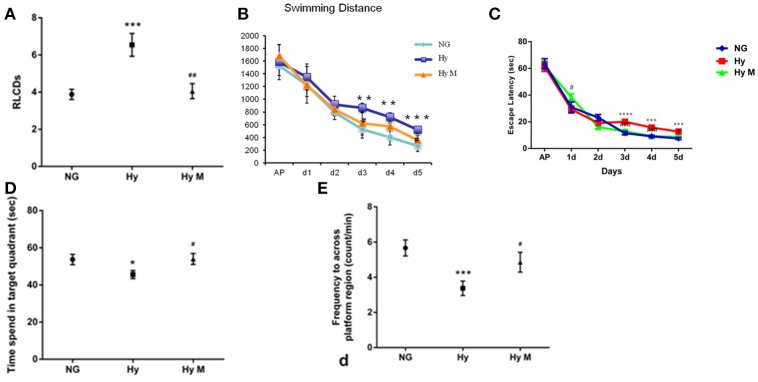
Learning and memory alterations after hypoxia with/without minocycline treatment. (A) In P30d rats, the average number of days that animals of indicated groups needed to reach RLCDs was obtained from Y-shape electronic maze test. ***p < 0.001 vs. the normal group (NG); ##p < 0.01 vs. the hypoxia group (Hy). n = 14–16 animals per group. (B) The swimming distance from day1 to day 6 in each group, **p < 0.01 and ***p < 0.001 vs. NG group; #p < 0.05 vs. Hy group. n = 16–20 animals per group. (C) Escape latencies in hidden-platform task during training in indicated groups. ***p < 0.001 and ****p < 0.0001 vs. NG group; #p < 0.05 and ###p < 0.001 vs. Hy group. n = 16–20 animals per group. (D,E) In the probe test of the Morris water maze test, the time spent in the target quadrant (D) and the number of times crossing the platform region (E) of indicated groups were measured. *p < 0.05 and ***p < 0.001 vs. NG group; #p < 0.05 vs. Hy group. n = 14–16 animals per group. Data expressed as means ± SEM. NG represents normal control rats; Hy represents hypoxia rats; Hy M represents hypoxia rats with minocycline treatment.